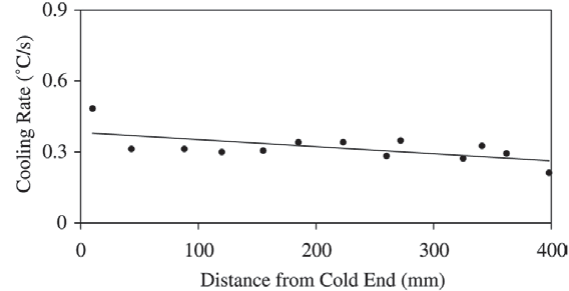
Figure 2. Cooling curves for different distances from the of cold end: 1) 23 mm; 2) 223 mm; 3) 398 mm.